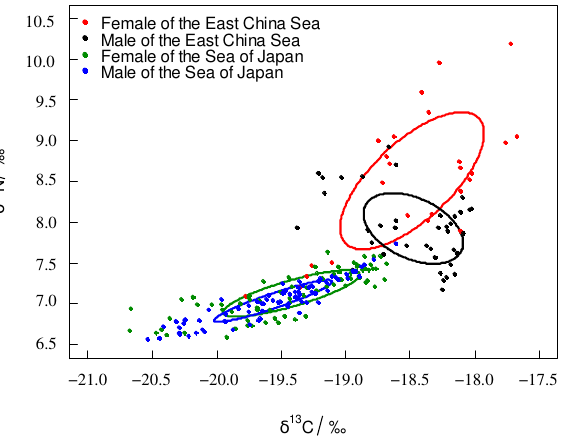
Figure 5. Trophic niche of T. pacificus of females and males collected in the different areas (circle plot: SEAc).